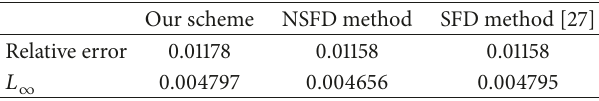
Table 9: Maximum norm relative errors and error norm 𝐿 ∞ of the proposed approximate-analytical solution, NSFD method, and SFD technique for Example 9.